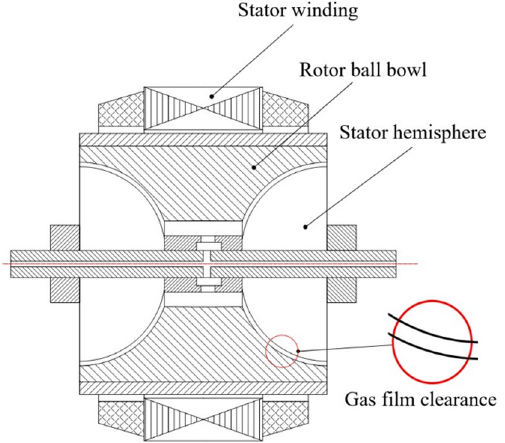
Figure 1. Schematic diagram of hemispherical dynamic pressure